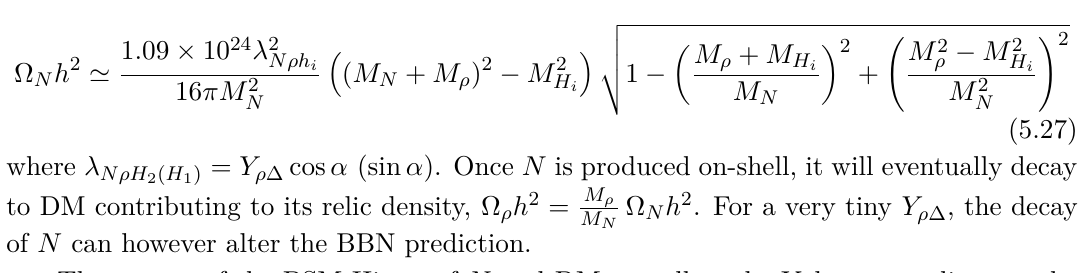
Figure 20 . Allowed points in the M H color bar in the LP and RP correspond to M and RP satisfy BBN